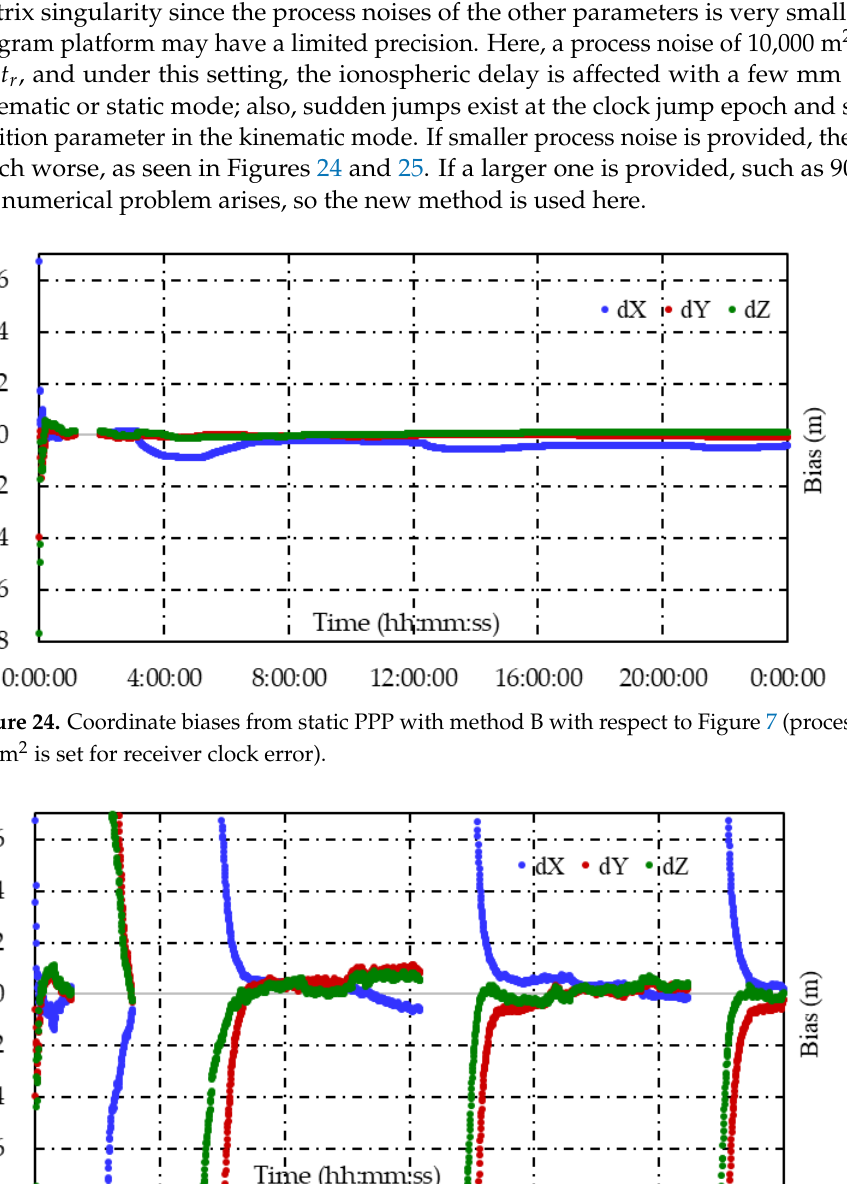
Figure 23. dSIONs between static PPP without and with MSJP corrections.